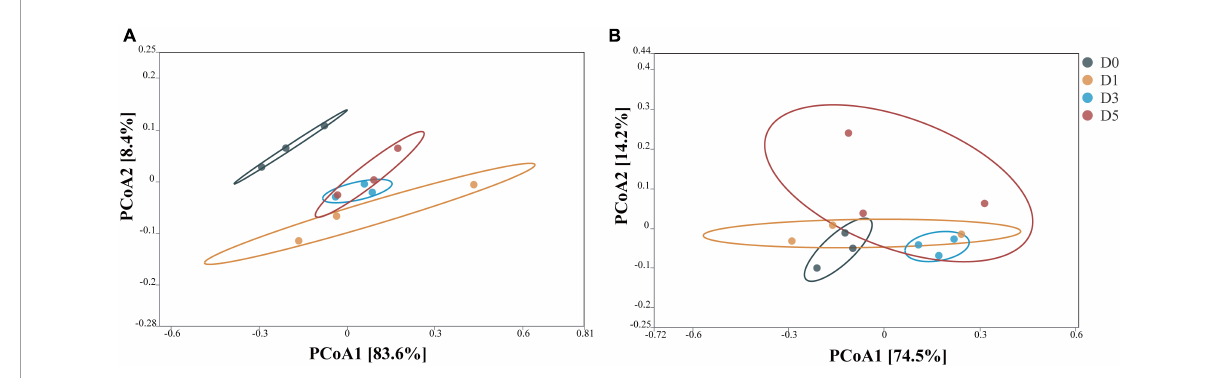
FIGURE1 Principal coordinate analysis (PCoA) of the bacterial community from corn stalk silage (A) and Pennisetum sinese silage (B) after 45 days of ensiling. D0, undiluted; D1, 10 - 1 dilution; D3, 10 - 3 dilution; D5, 10 - 5 dilution.